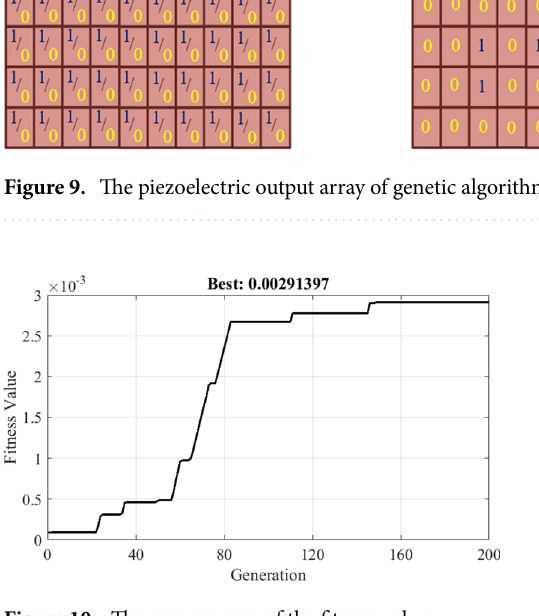
Figure 10. The convergence of the fitness value.